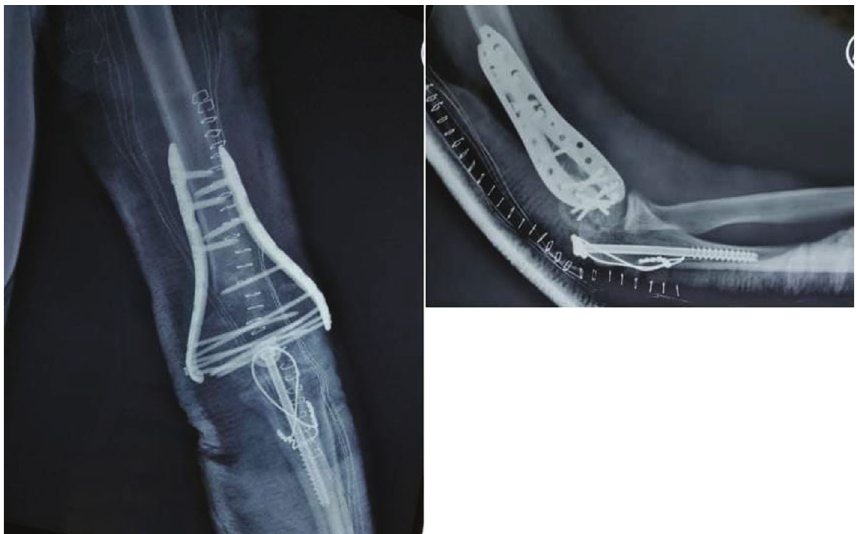
Figure 2: Postoperative radiographs of the